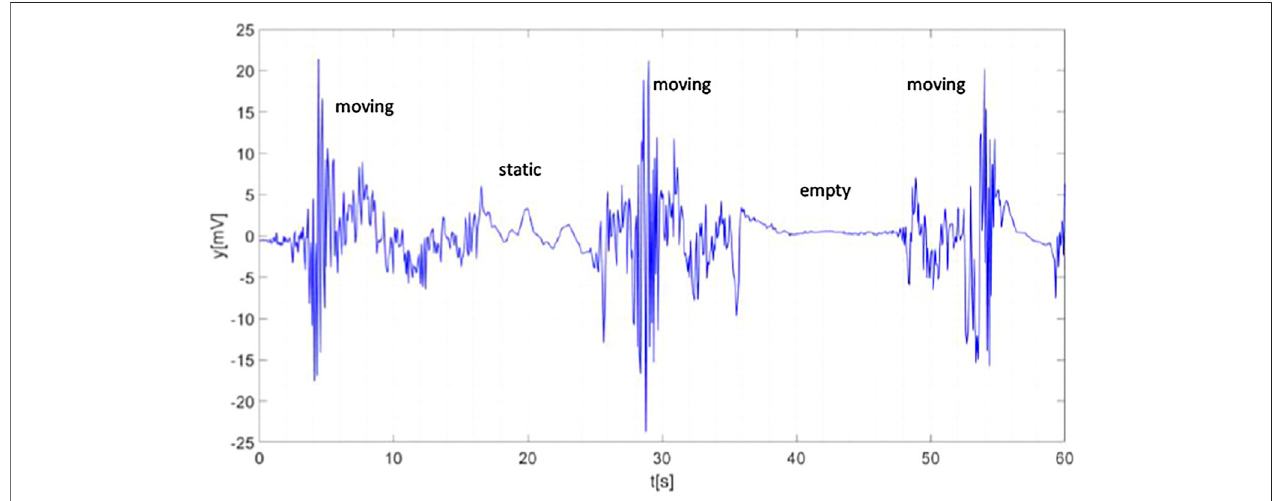
FIGURE 6 | Radar signal after mean value fi ltering. Labels denote the actions performed by the subject.